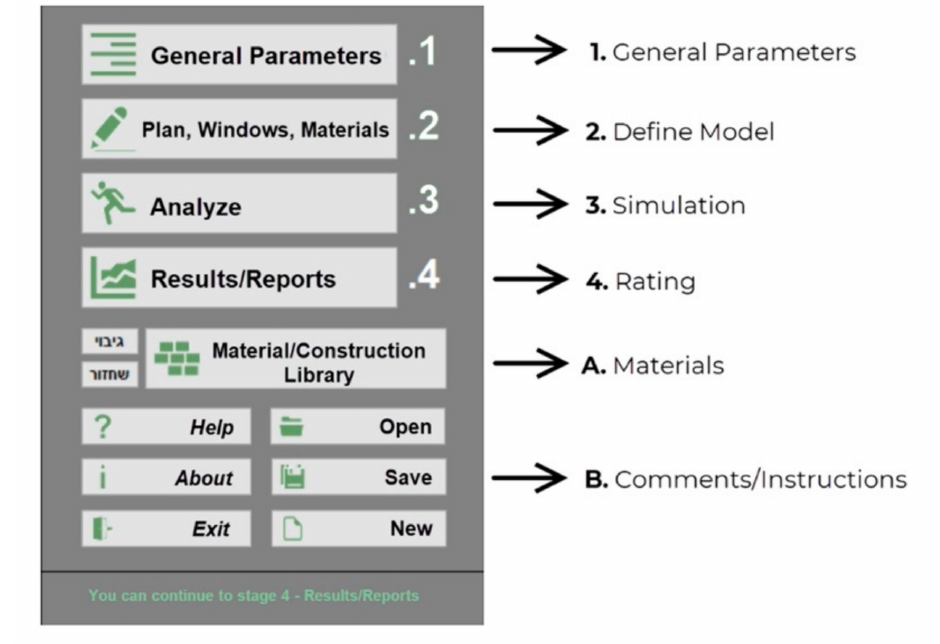
Figure 2. Command tool